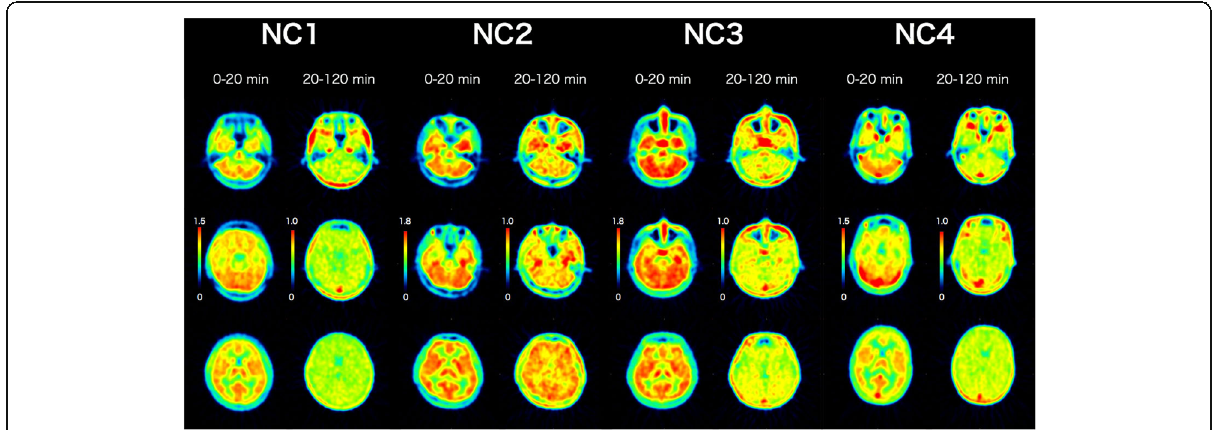
Fig. 3 PET images of four healthy subjects after injection of [ 11 C]HMS011. Horizontal PET images were obtained by averaging from 0 to 20 min and 20 to 120 min after injection of [ 11 C]HMS011. Images were shown at the level of the cerebellum ( top ), pons ( middle ), and thalamus ( bottom